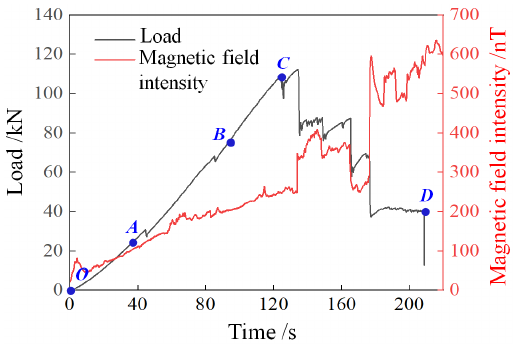
Figure 13. Variation curve of MFI of concrete containing magnets under loading failure.